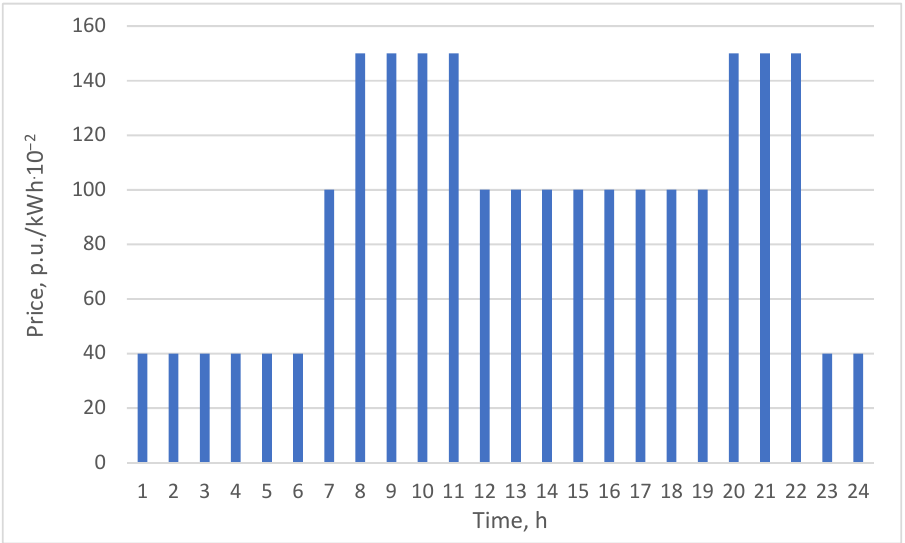
Figure 6. Structure of the electricity tariff.